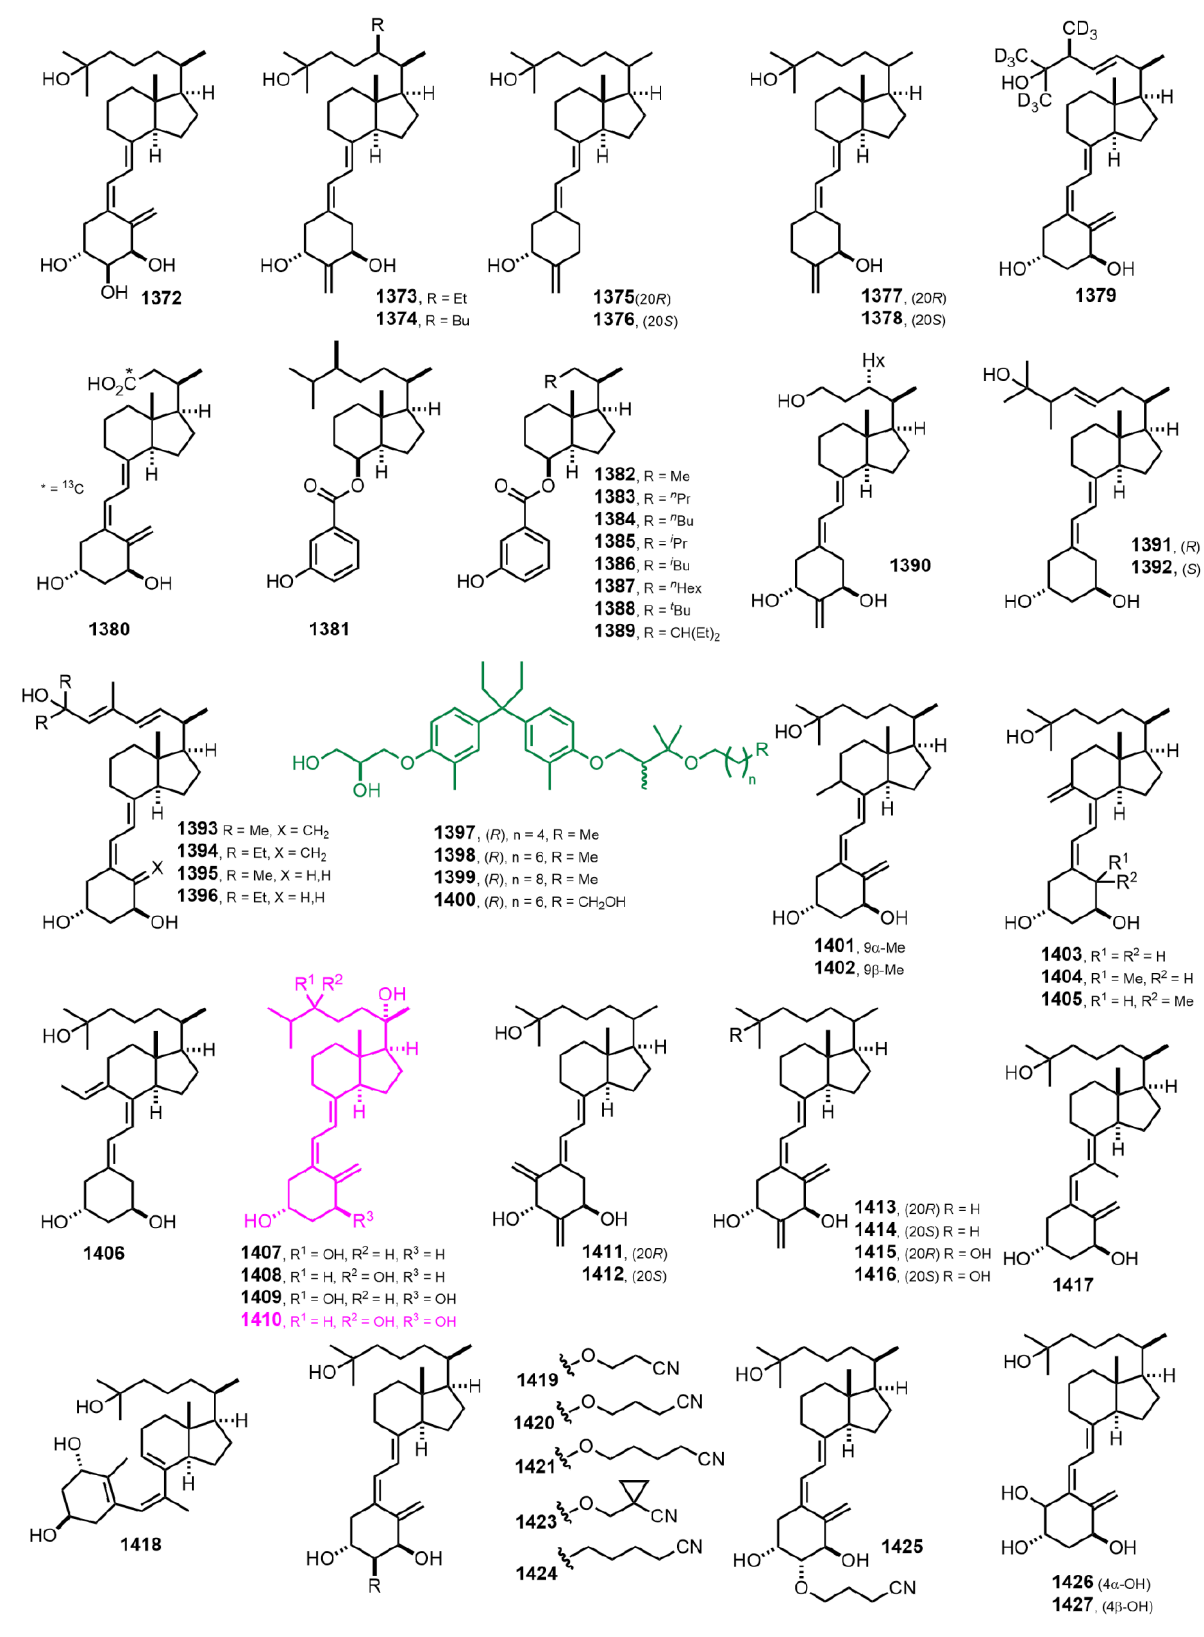
Figure 24. (2014–2015)